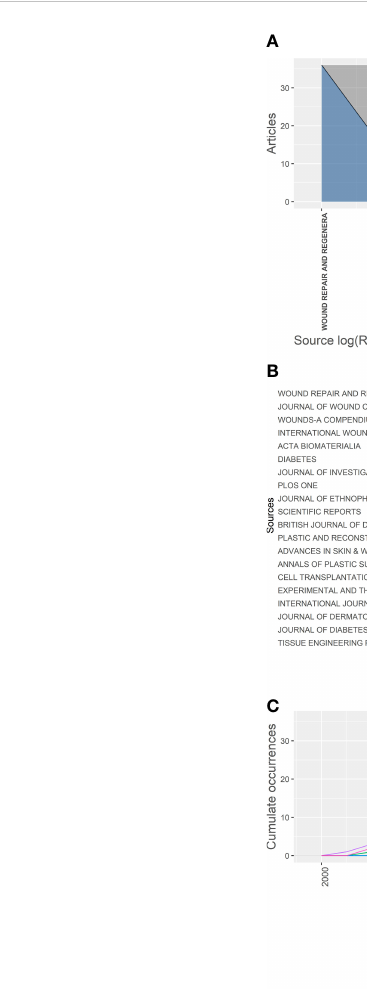
the node size represents the popularity; the line between the nodes indicates the intimacy between the keywords.